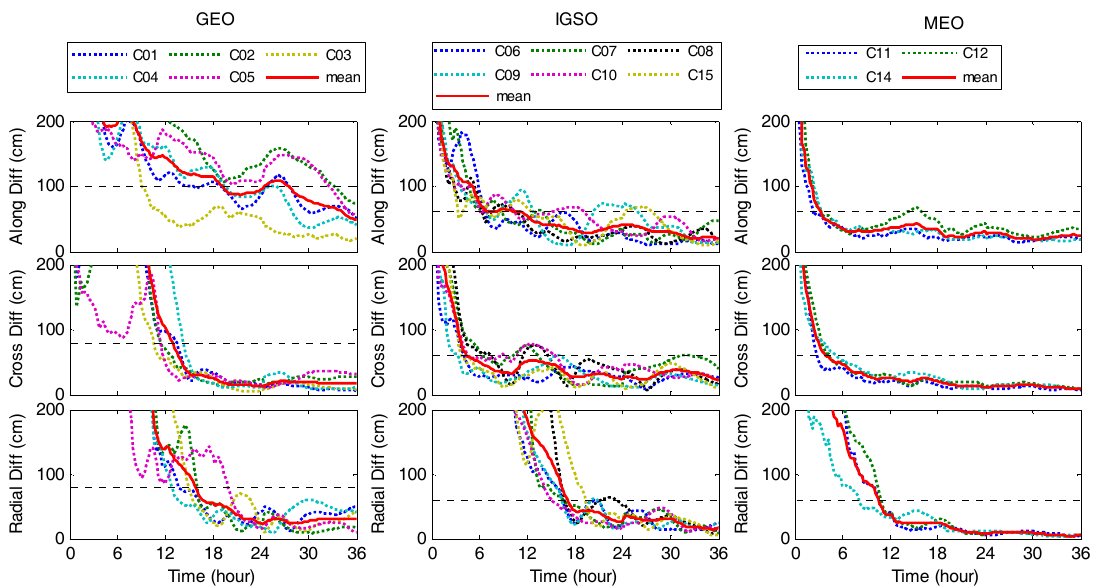
Figure 3. Time series of the average accuracy of the reference orbit. The red line represents the average time series of the satellites of the same type. The horizontal black dotted line represents the convergence criteria for each direction.